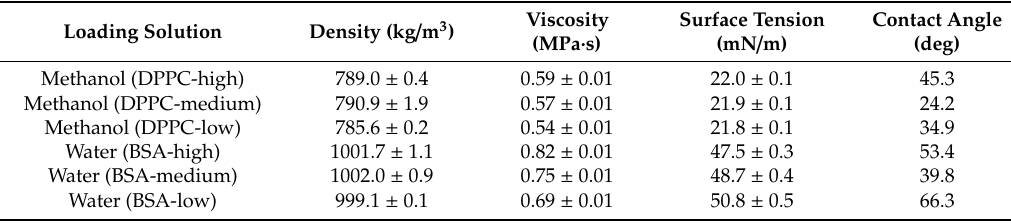
Table 1. Physical properties of loading solutions. For density, viscosity, and surface tension, values are means ± SD ( n = 3). Contact angle was calculated based on values from the table and the averaged results from the sorption measurements ( n =